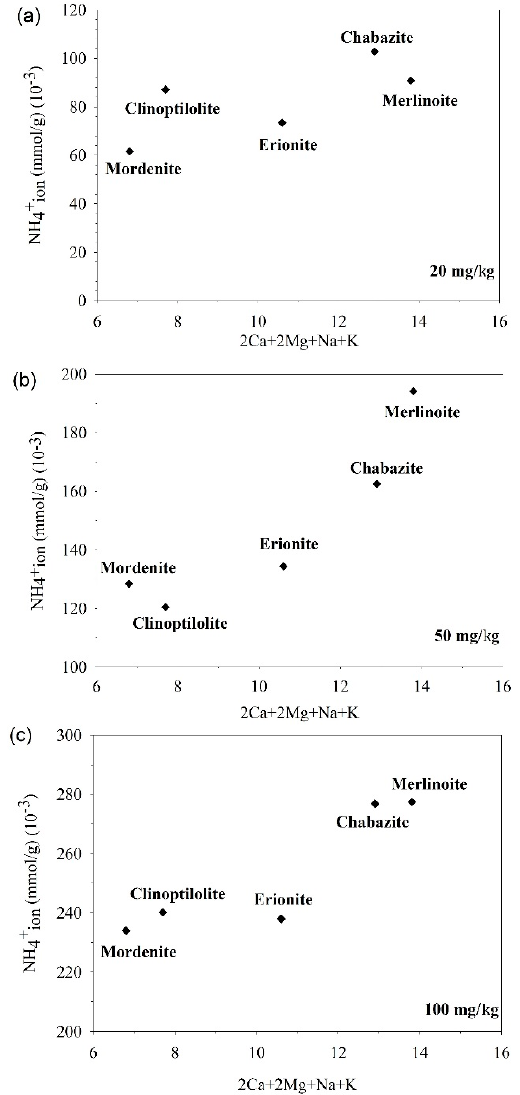
Figure 5. Relationship between IA and IIA cation content and ion exchange capacity in initial concentrations of ( a ) 20 mg/kg, ( b ) 50 mg/kg, and ( c ) 100 mg/kg.